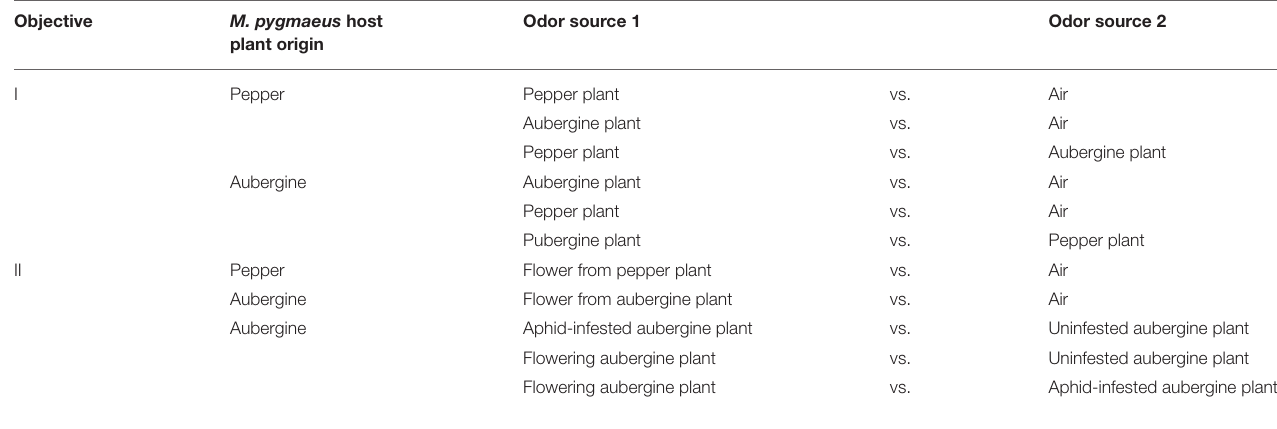
TABLE 1 | Olfactometer bioassays involving M. pygmaeus nymphs originating either from pepper or aubergine plants (see details in the Materials and Methods).